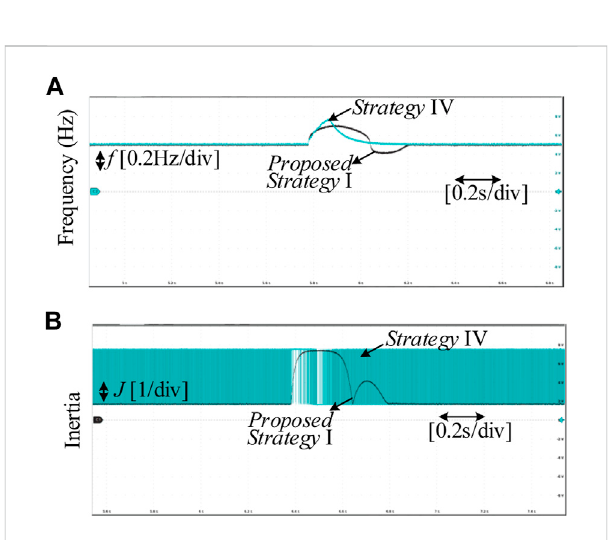
FIGURE 12 Experimental results of Scenario 3. (A) Frequency of GFM inverter. (B) Inertia of GFM